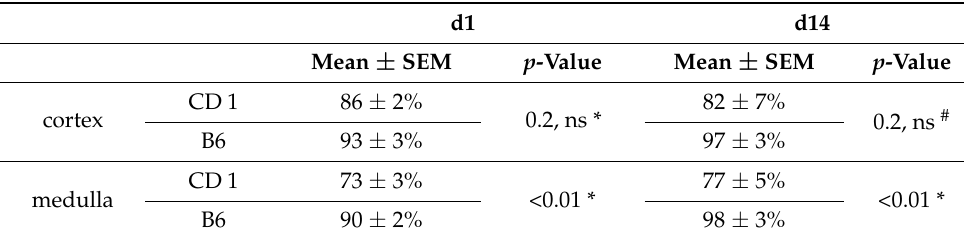
Table 1. Relative values of ADC maps at d1 and d14 after 35